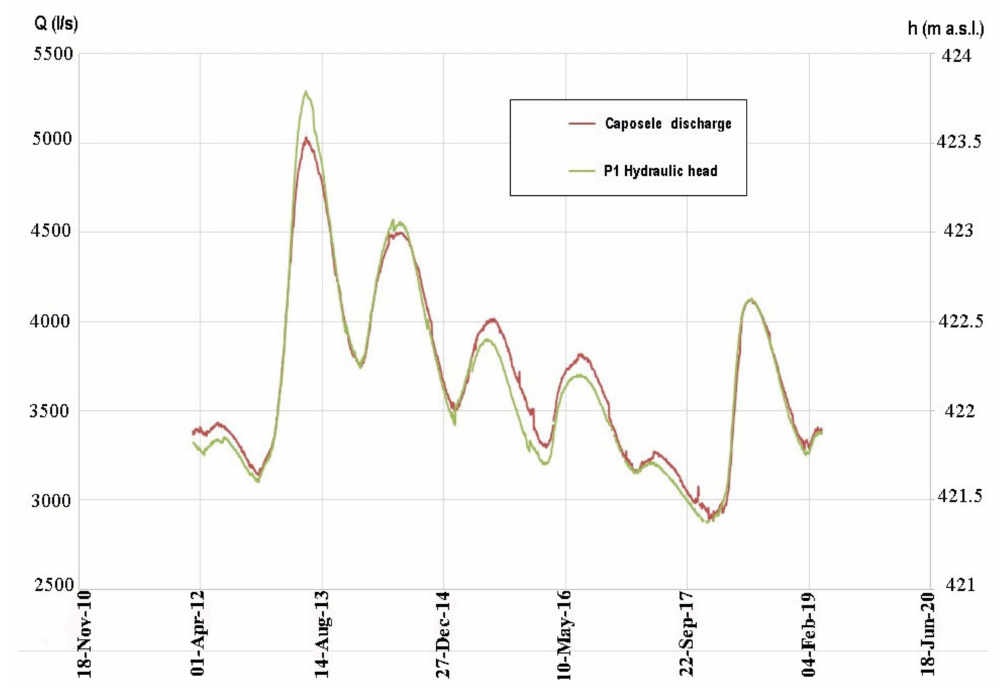
Figure 5. The Caposele spring discharge, Q , and the hydraulic head of the P1 borehole, h , March 2012 – March 2019